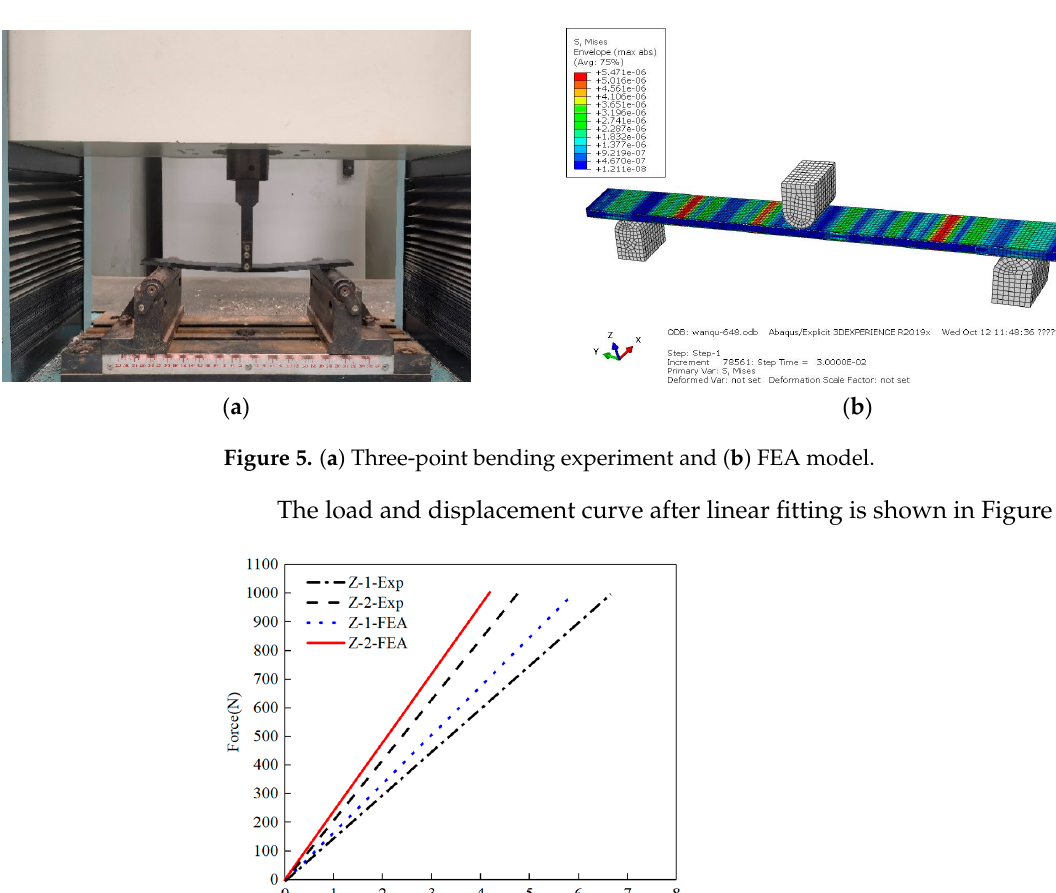
( c ) Figure 4. ( a ) Front view of specimens, ( b ) Side view of CFRP laminate with periodic structures, and ( c ) The specimen fabrication process. 4.2. Bending Stiffness of the CFRP Laminate with Periodic Structures